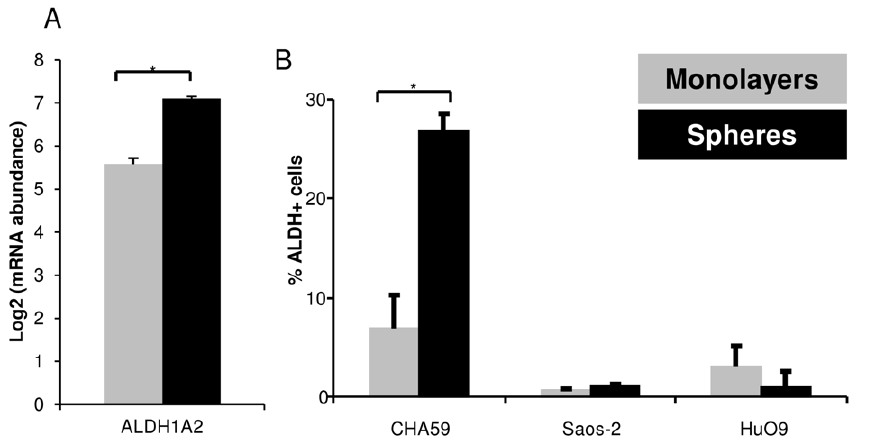
Figure 5. Heterogeneous aldehyde dehydrogenase ( ALDH ) expression in monolayers vs. spheres. (A) Aldehyde dehydrogenase 1 family, member A2 (ALDH1A2) transcript in CHA59 monolayers (gray bar) and spheres (black bar) measured by microarray analysis, * p , 0.05. (B) Percentage of ALDH expressing cell population in CHA59, Saos-2, and HuO9 monolayers and spheres measured by ALDEFLUOR assay. *p , 0.05.